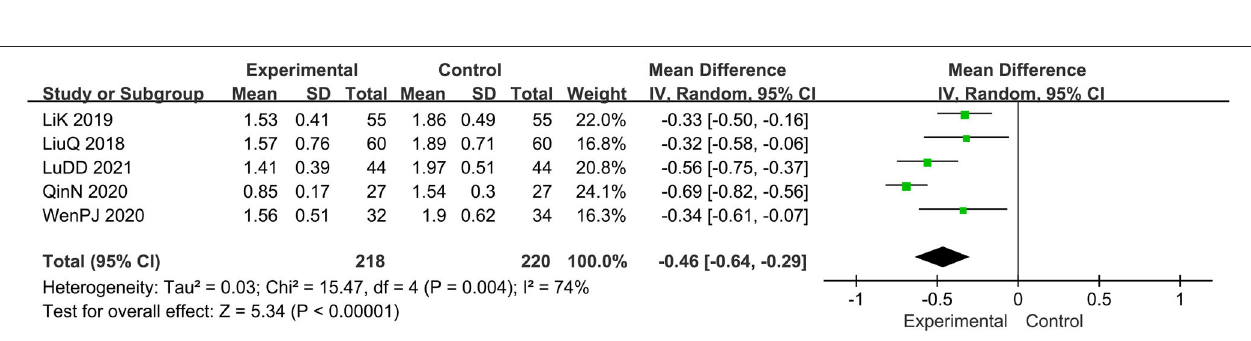
FIGURE 3 | The meta-analysis for comparison of combination therapy vs. prednisone for the outcome of the clinical efficacy rates.